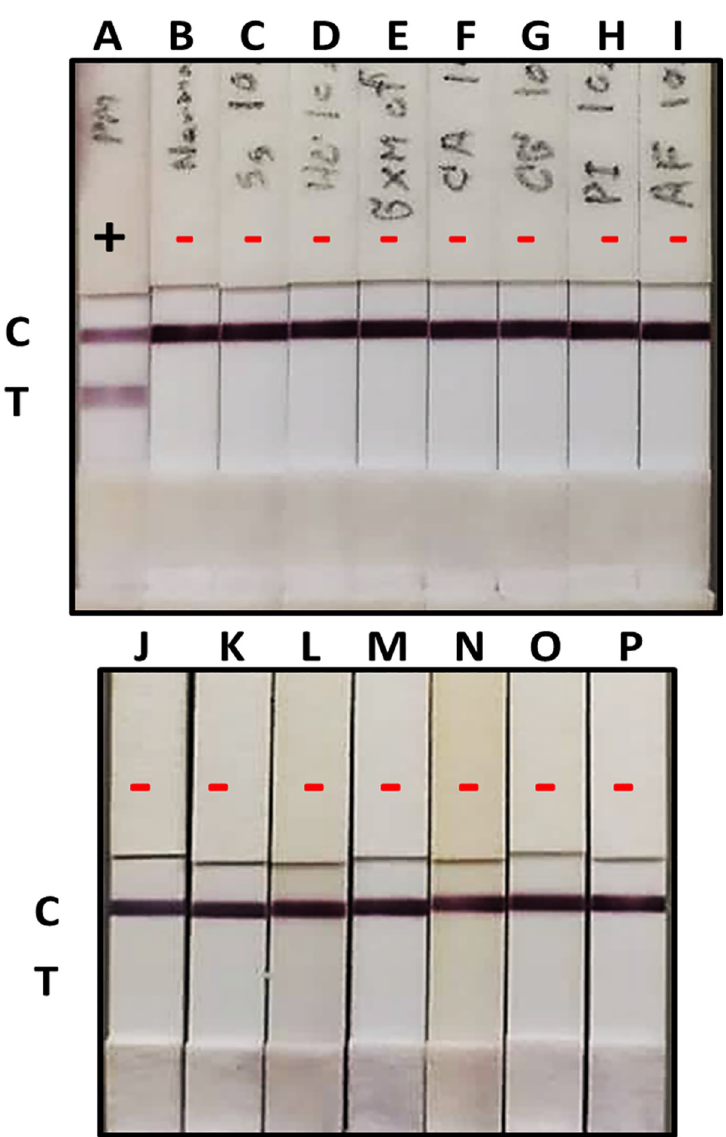
Fig 7. Specificity of the GNA-MAb 4D1 sandwich ICT strip. Normal urine samples from healthy individuals were spiked with various pathogenic fungal antigens at 10 μ g/ml. A, TM CYA (served as a positive control); B, normal healthy urine sample (served as a negative control); C, S . schenckii CYA; D, H . capsulatum CYA; E, C . neoformans GXM; F, C . albicans ; G, C . glabrata ; H, P . insidiosum ; I, A . fumigatus ; J, P . citrinum ; K, P . chrysogenum ; L, P . boydii ; M, C . krusei ; N, Trichosporon spp.; O, Geotrichum spp.; and P, TM CMA. Abbreviations: CYA, Cytoplasmic Yeast Antigen; CMA, Cytoplasmic Mycelium Antigen C, control line; T, test line.